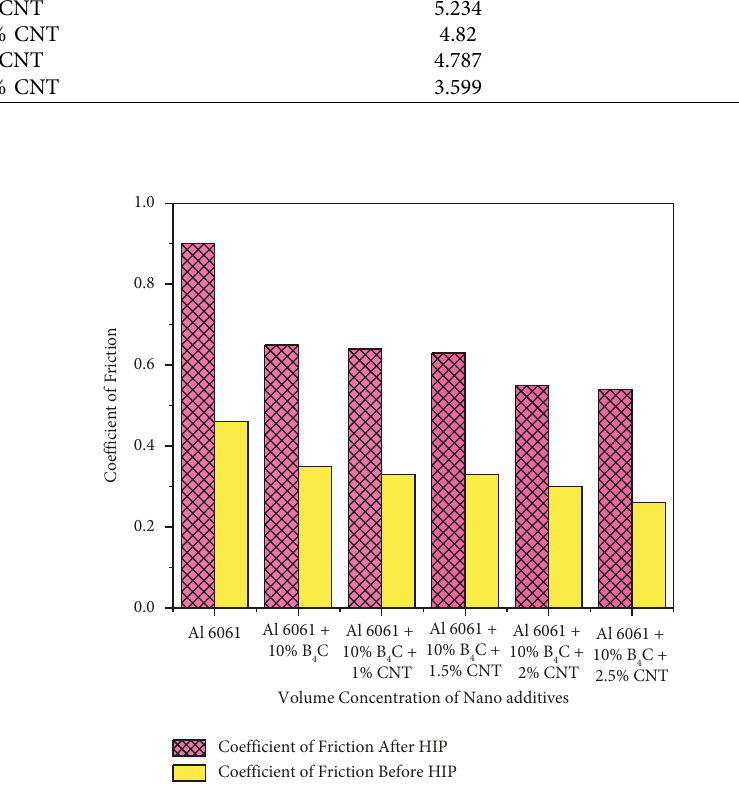
Figure 6: The friction coefficient of before and after